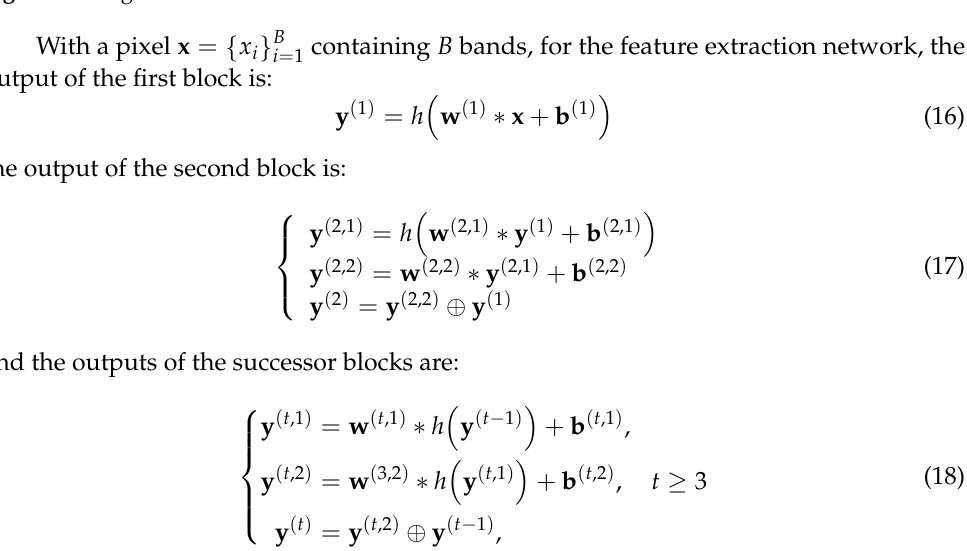
Figure 14. Target detection